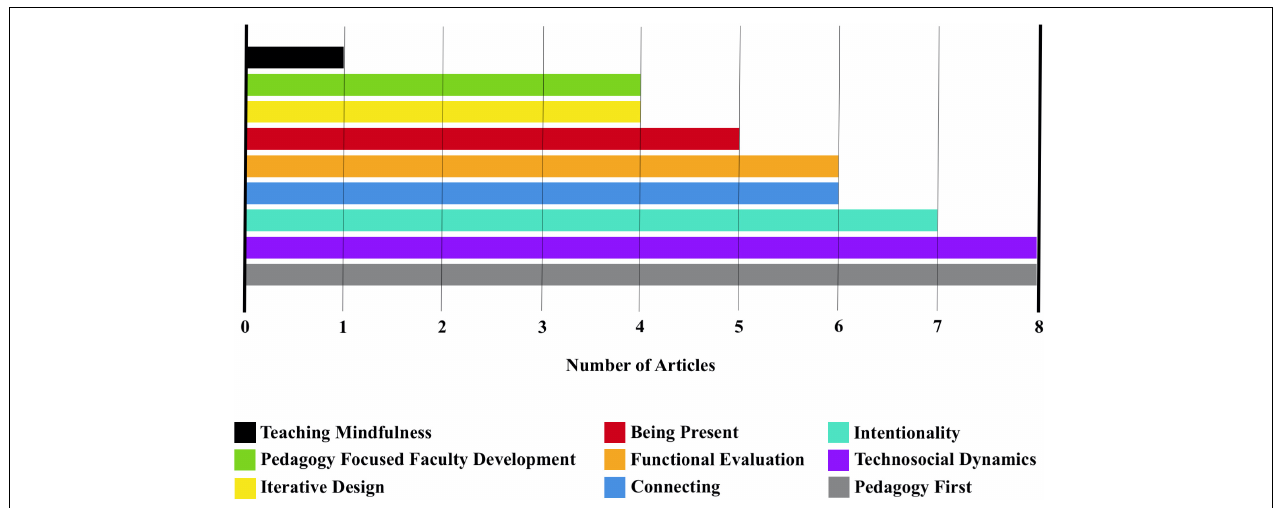
FIGURE 4 | Sub themes generated from discourse analysis of The Chronicle of Higher Education for attributes of contemplation in pedagogy and technology theme. The bar chart only includes articles that were coded as contemplative. An addition 88 articles were coded as not contemplative.